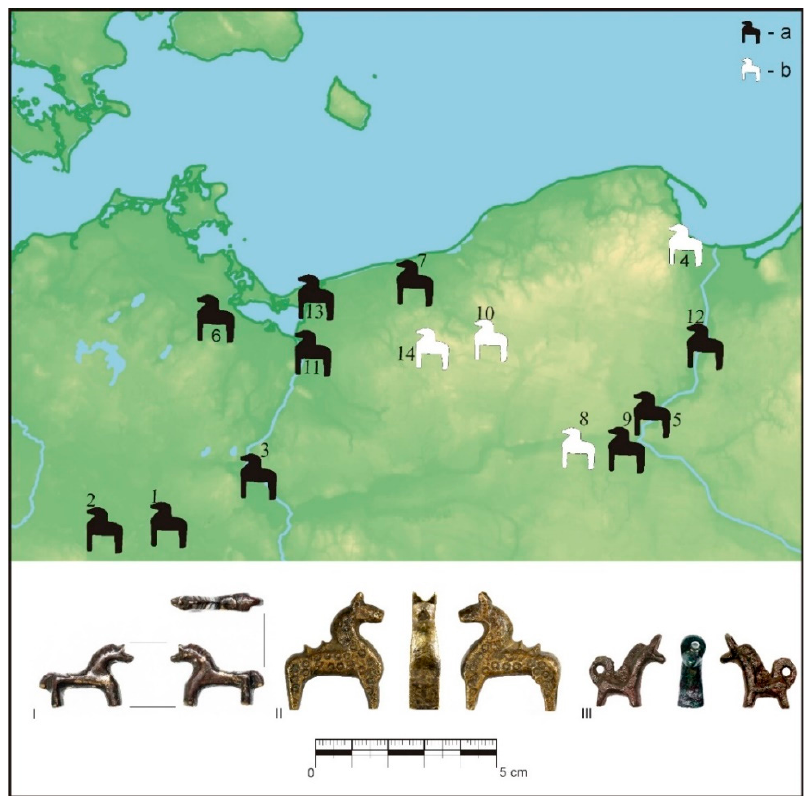
Figure 8. Sites with miniature horse figurines discovery in the northwest Slavic region, types of material according to Szczepanik [103]: a) black—copper alloys; b) white—wood; 1) Berlin-Spandau, 2) Brandenburg; 3) Cedynia, 4) Gda ń sk, 5) Ka ł dus, 6) Krien, 7) Ko ł obrzeg-Budzistowo, 8) Nak ł o at Spandau, (2) Brandenburg; (3) Cedynia, (4) Gda´nsk, (5) Kałdus, (6) Krien, (7) Kołobrzeg-Budzistowo, Note ć , 9) Paw ł ówek, 10) Pars ę cko, 11) Szczecin-Podzamcze, 12) Tymawa, 13) Wolin, 14) Ż ó ł te; (8) Nakło at Note´c, (9) Pawł ó wek, (10) Pars˛ecko, (11) Szczecin-Podzamcze, (12) Tymawa, (13) Wolin, (drawing by P. Szczepanik). (14) ˙Z ó łte; (drawing by P.